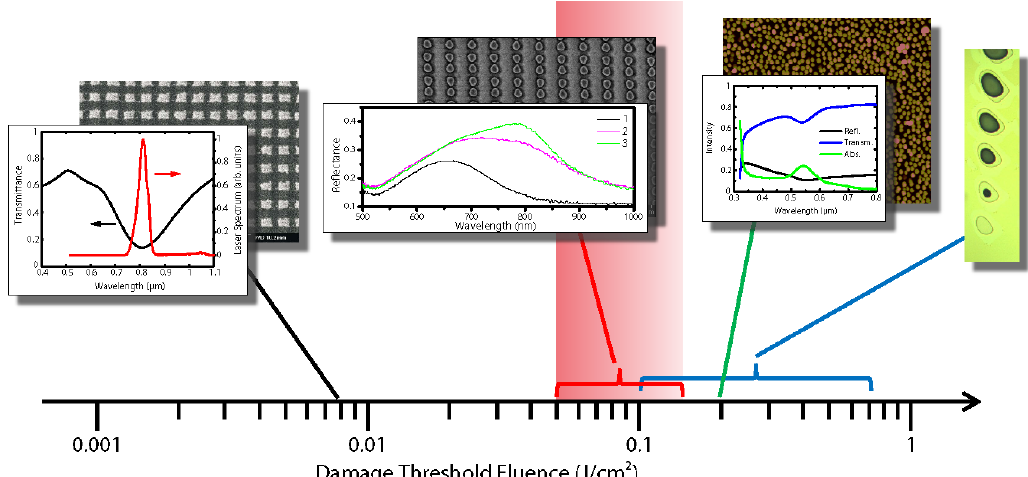
Figure 14: Evaluated single shot damage threshold fluences of gold structures using femtosecond irradiation (left to right: resonant SERS rectangles, various bow-tie geometries, non-resonant nano-spheres, unstructured gold layers). a more refined study, they comprehensively compared results from bow-tie-enhanced emission from noble gas atoms with conventional HHG, using estimated numbers and experimentation [40]. They conclude that the sum of the point-like regions of emission from the enhanced-field- regions of the antennas, under the absence of any on- axis phase matching mechanisms, will never be as promi- nent as the incoherent ALE features they dependably de- tect. Years after the original scheme has been published, a fullevaluationof thepotentialofnano-plasmonic-assisted HHG remains